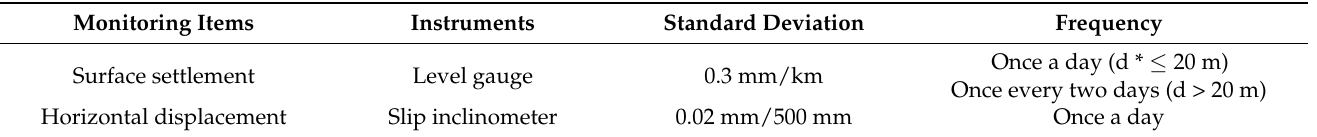
Figure 2. Layout of monitoring points of the representative cross section. Table 2. Detailed information of field monitoring of displacement.